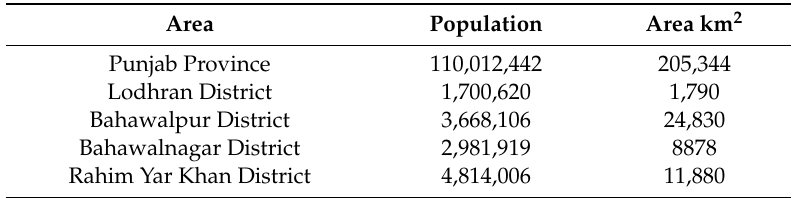
Table 1. Population and area.